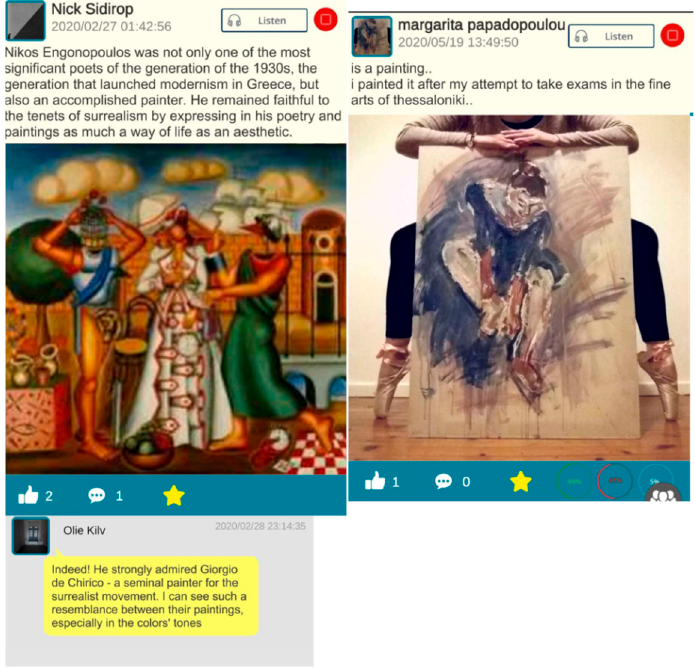
Figure 18. Examples of users’ posts shared to their timelines.